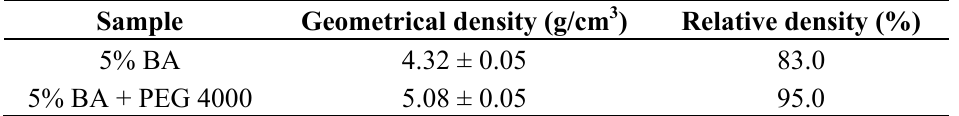
Table 2. Density of the 5 wt % barium-doped hematite pellets with and without PEG addition.